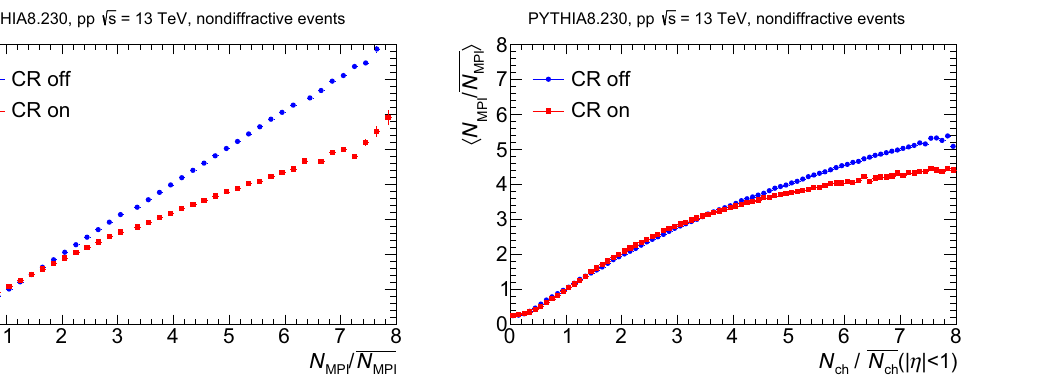
Fig. 2 Left: Mean self-normalized charged-particle multiplicity in | η | < 1 as a function of the self-normalized number of MPI for acti- vated and deactivated colour reconnections (CR) in PYTHIA8. Right: